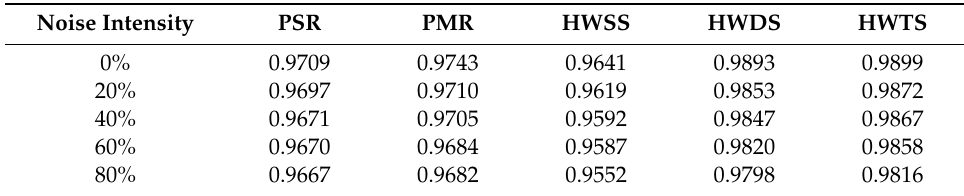
Table 4. The accuracy reduction in coefficient of determination for different models under various noise intensities.